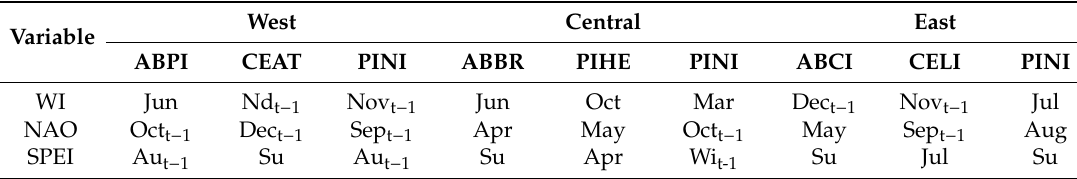
Table A1. Selected months or seasons for the moving correlations between TRWi and WI, NAO, and SPEI for each of the six di ff erent sites for 1902–2010. Abbreviations correspond to months and seasons of the previous (t − 1) and current years, respectively. Seasonal climate data: Au, autumn; Wi, winter; Sp, spring, Su,